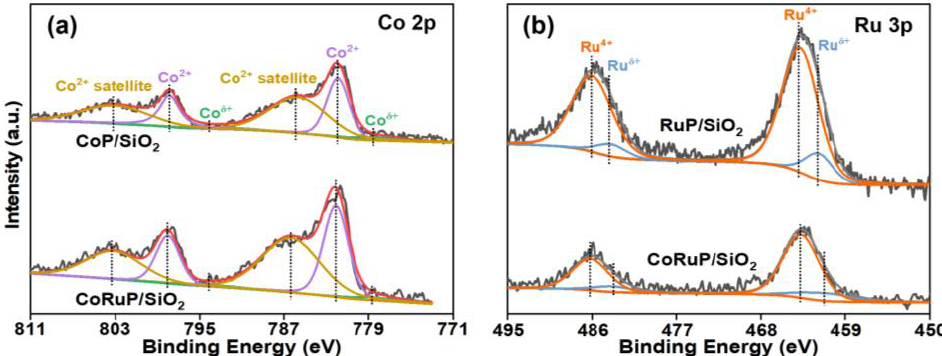
Figure 4. X-ray photoelectron spectrum of CoRuP/SiO 2 in ( a ) Co 2p and ( b ) Ru 3p regions.